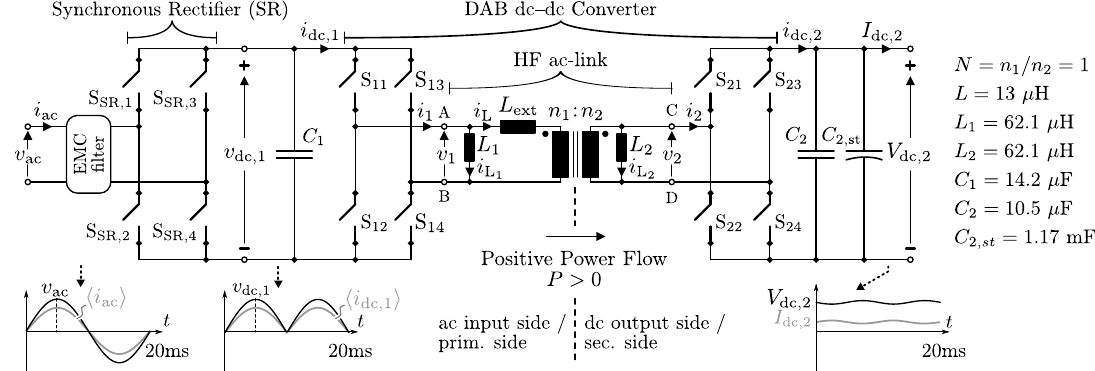
Figure 1. Schematic of the single-stage (1-S), single-phase, bidirectional, isolated dual active bridge (DAB) ac-dc converter topology. The nominal ac input voltage, input current, and power are respectively 230 V rms , 16 A rms , and 3.7 kW, while the specified output voltage range is V dc,2 = 370–470 V, with V dc,2,nom = 400